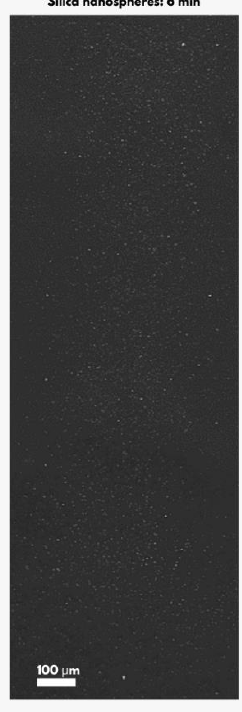
Figure 7. TSEM images (Magnification: 25×, Accelerating voltage: 15 kV) of the coarse stage samples showing silica microspheres collected for 6 min.